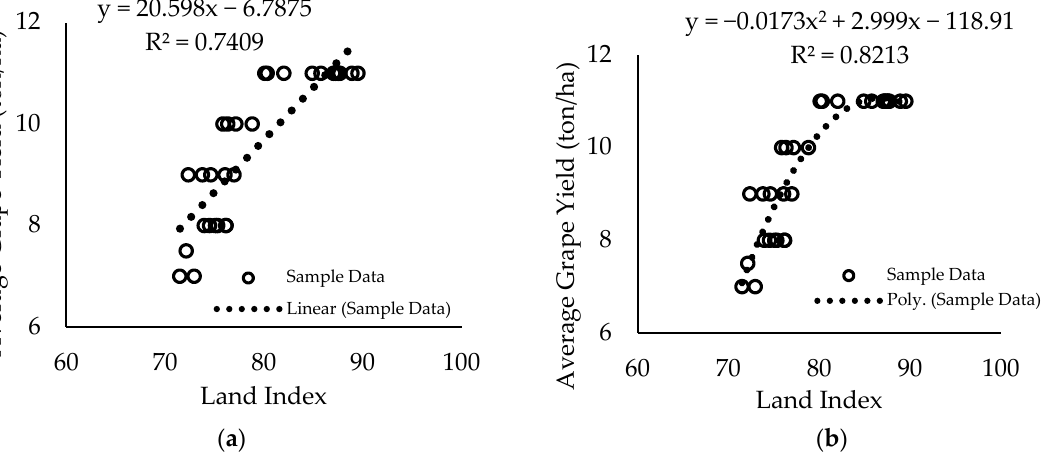
Figure 8. Validation of the fuzzy-based land suitability score referring to the average grape yield from different provinces in Afghanistan. ( a ) linear regression and ( b ) polynomial regression.